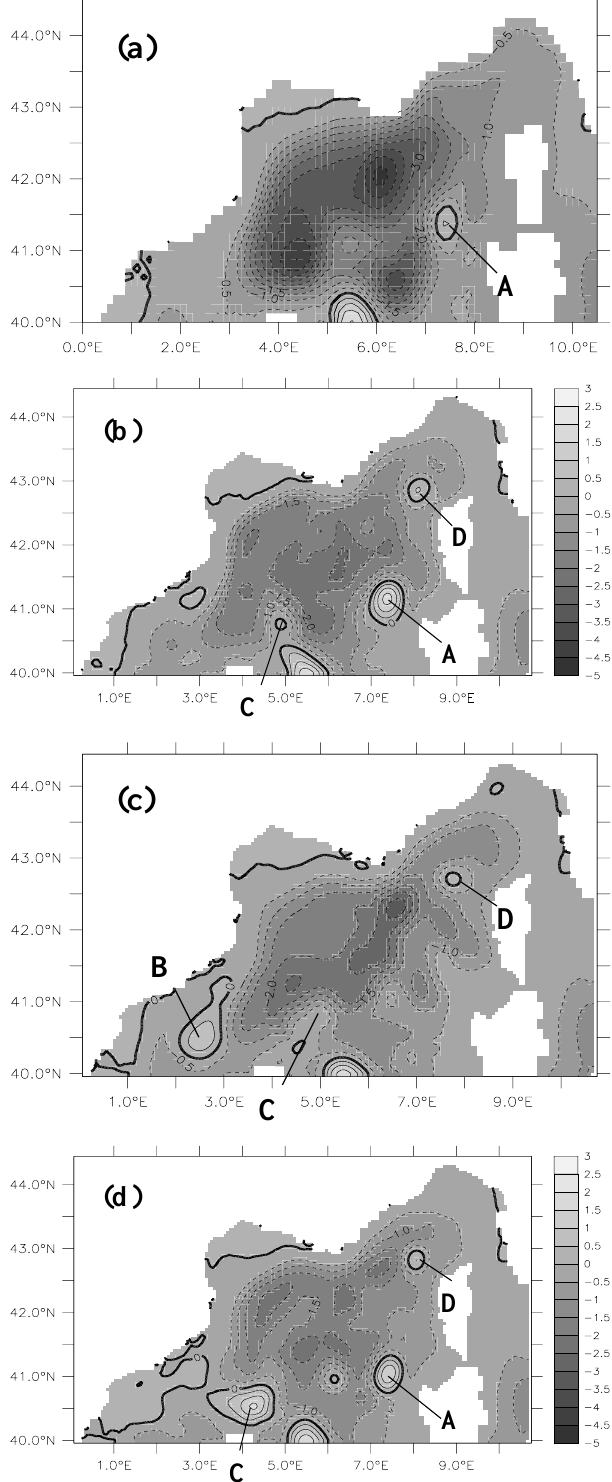
Fig. 3. Annual mean barotropic stream function for: (a) the GM; (b) the RM, year I; (c) year II; (d) year III. Isoline units are in Sverdrups (Sv), 0.5-Sv intervals. (A), (B), (C) and (D) denote